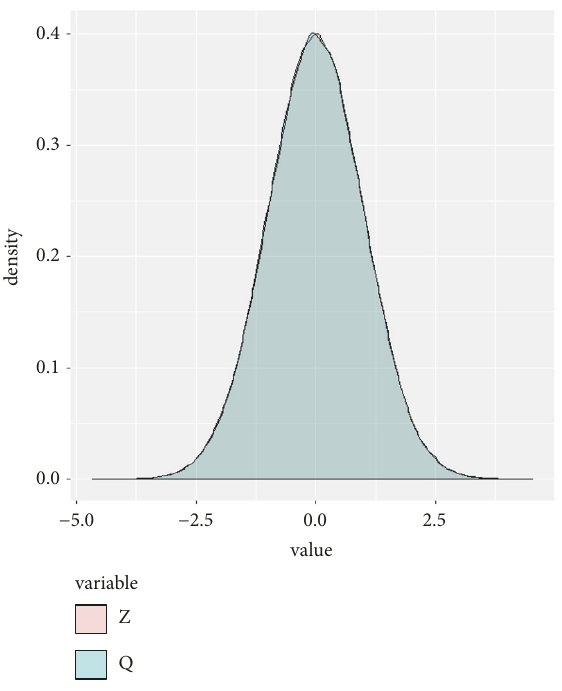
Figure 4: Kernel density plot of 𝑍 and 𝑄 at 𝑛 = 6 , 𝑇 = 𝑀𝑅𝑆𝑆 , and 𝜌 = 1 . 𝑋𝑌